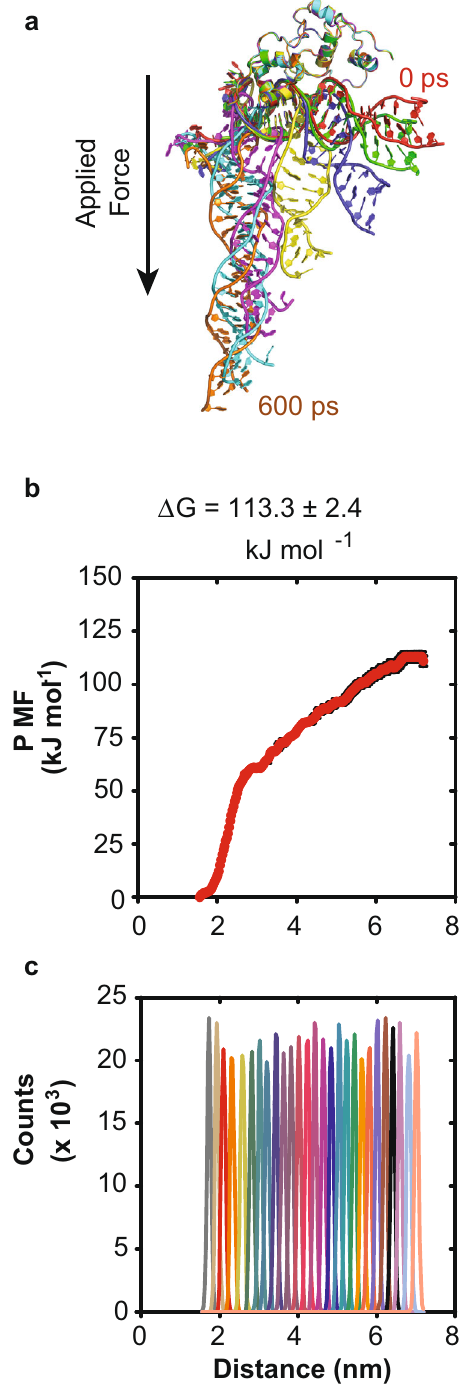
Stoperator domains to DNA binding, we applied a steered molecular dynamics (SMD) technique known as center-of-mass pulling (COM pulling) to induce dissociation of DNA from the repressor, allowing for calculation of dissociation free energy values. Figure 6a provides a visual overview of DNA dissociation with applied force and highlights that the HTH and Stoperator domains do not simultaneously release the initially bound DNA. The Stoperator domain is observed to dissociate from the DNA fi rst, followed by the HTH domain. After a 600 ps force appli- cation, the DNA is fully dissociated from the repressor. These